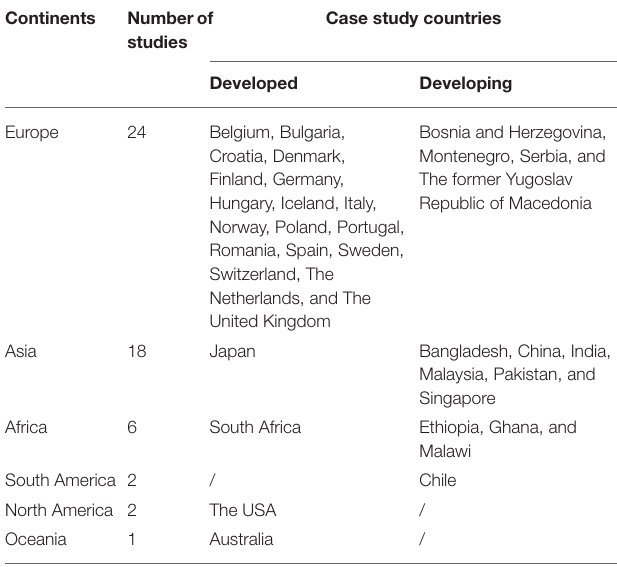
TABLE 1 | Articles reviewed, by continent and economic status of countries studied (developed and developing). Continents Numberof